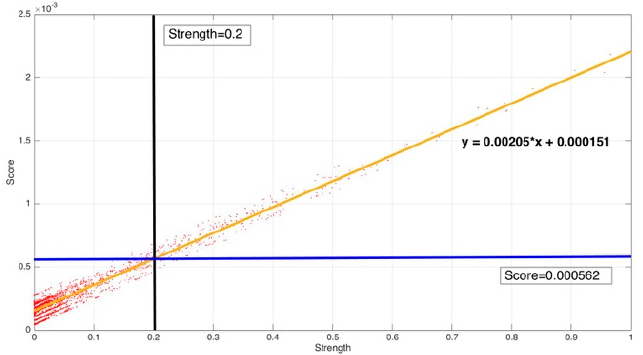
Figure 13. Correlation between strength and score.